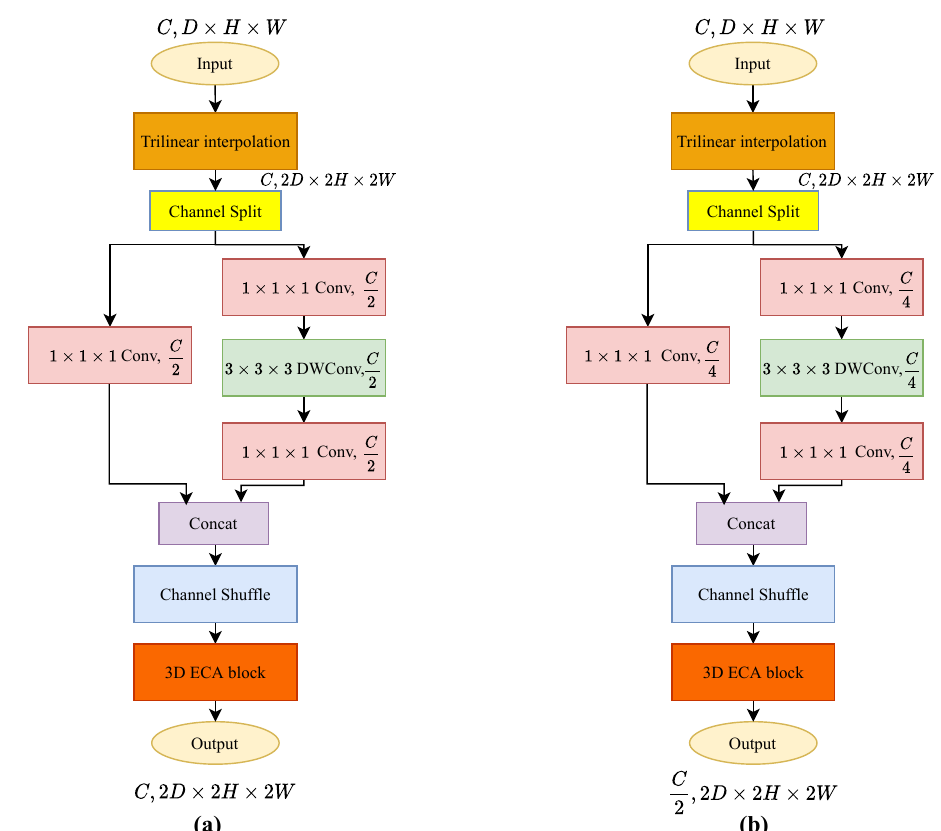
Figure 6. The trilinear interpolation upsamples the input to roughly twice the size of cost volume, then the 3D ECA-ShuffleNetV2 refines the resolution of cost volume with parameterized layers. ( a ) 3D Transposed ECA-ShuffleNetV2 at 3 DStack 5_ x layer. ( b ) 3D Transposed ECA-ShuffleNetV2 at 3 DStack 6_ x